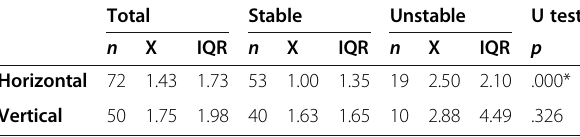
Table 4 Descriptive statistics and significance probabilities of horizontal and vertical variables Total Stable